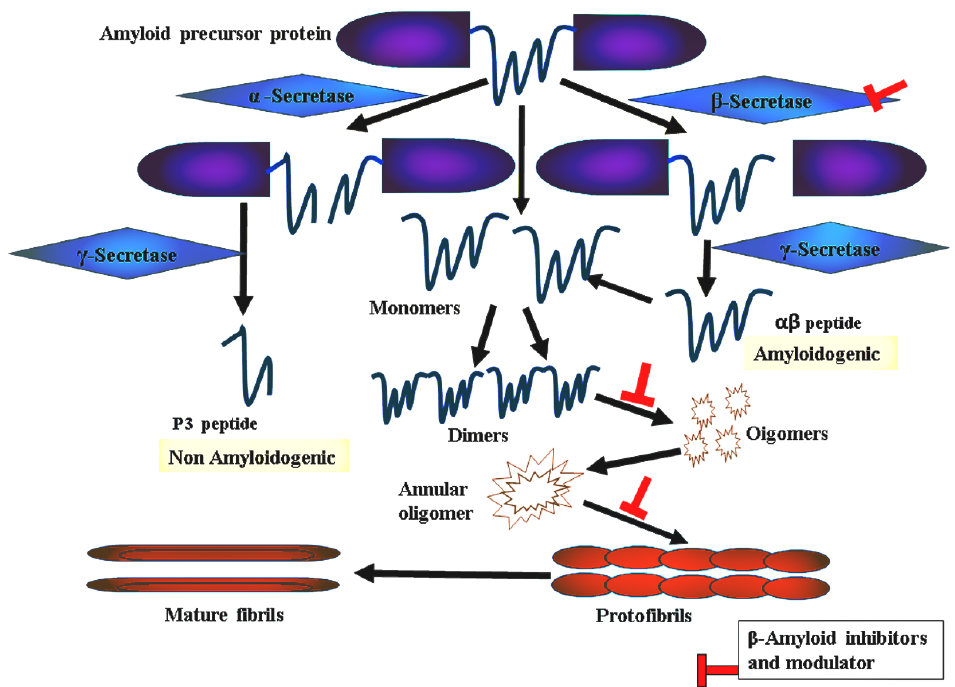
Figure 1. Schematic representation of amyloid plaque formation.